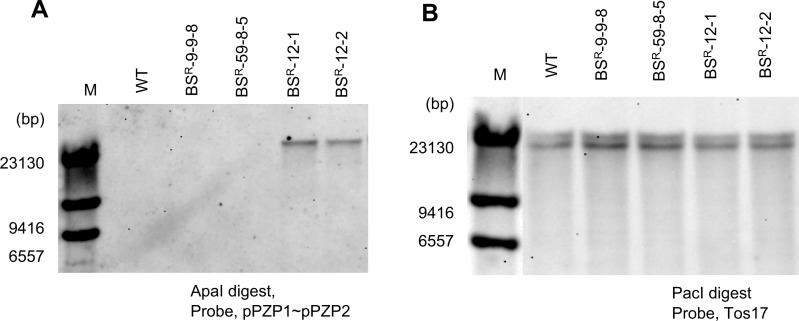
Confirmation of vector backbone insertion and Tos17 transposon copy number. (A) Southern blot analysis of ApaI-digested genomic DNA of BSR-9-9-8, BSR-59-8-5, BSR-12-1 and BSR-12-2 using a probe located on the vector backbone (Fig. 1A). (B) Southern blot analysis of BSR-9-9-8, BSR-59-8-5, BSR-12-1 and BSR-12-2 using a probe located on the Tos17 transposon.